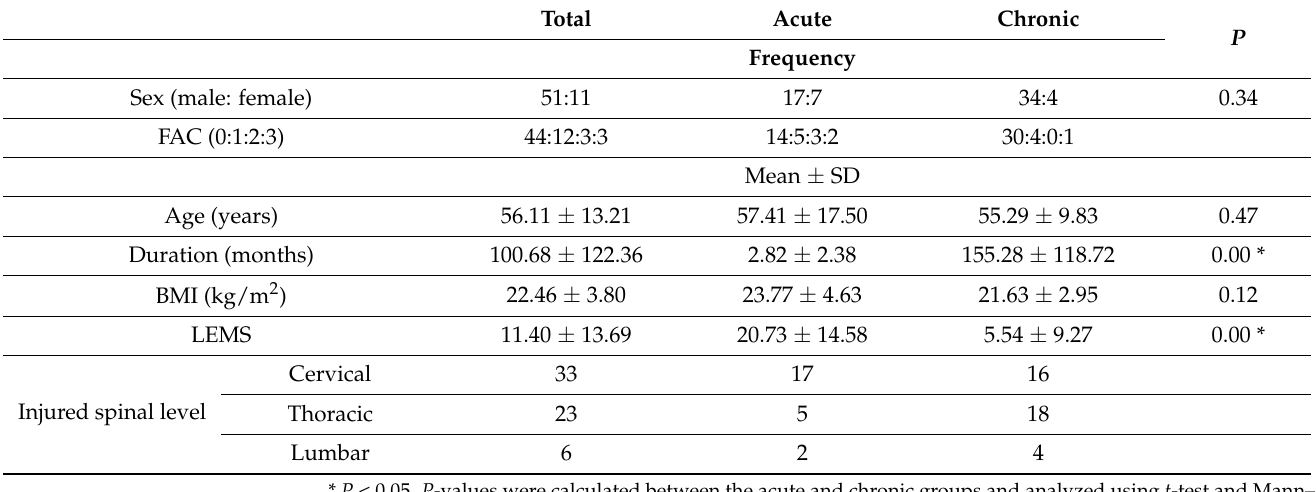
Table 1. Demographic data.